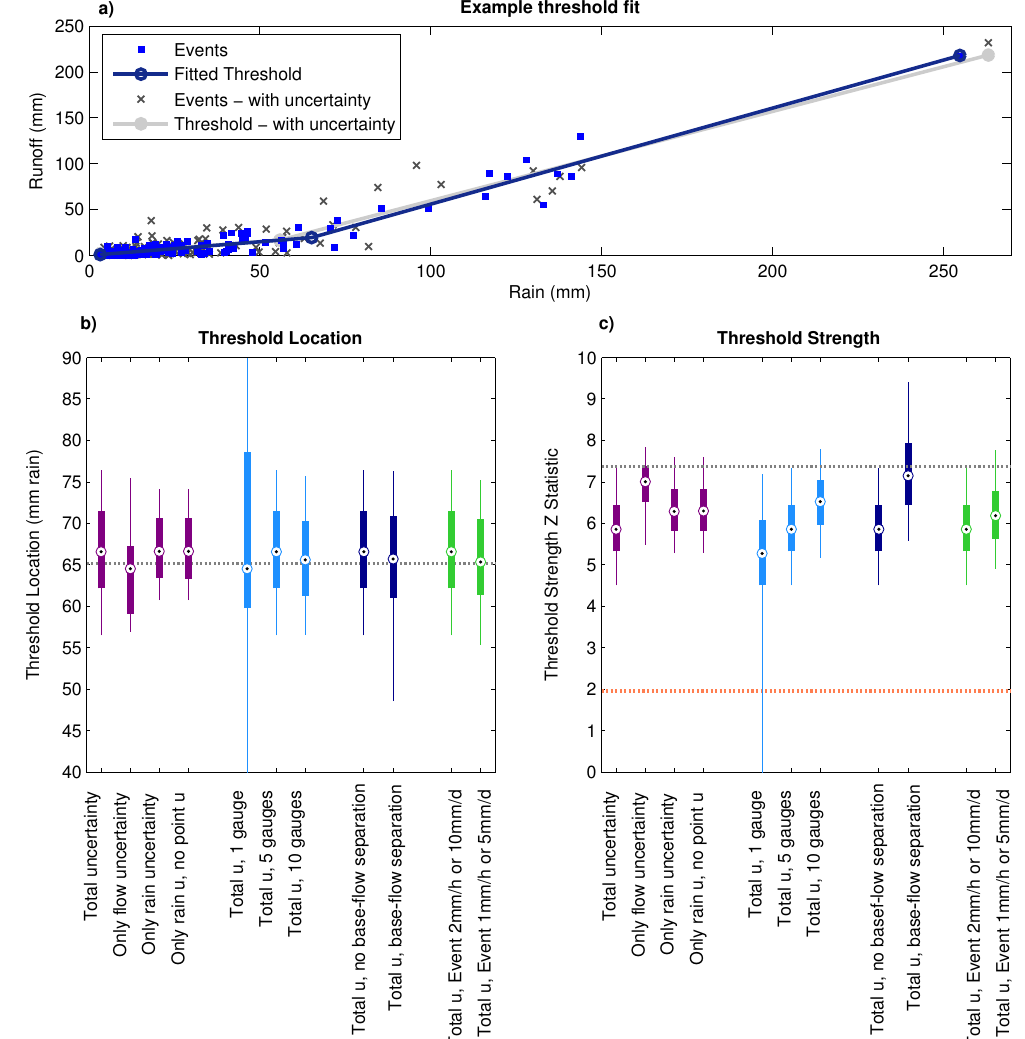
Figure 10. (a) Example of the threshold fitting procedure without (blue) and with (grey, one-rain-gauge scenario) uncertainty (u). Boxplots of (b) threshold location and (c) threshold strength in the Mahurangi catchment, under different data and subjective uncertainty scenarios. Horizontal grey lines show baseline signature values from the optimal rating-curve and precipitation data. The orange line in Fig. 9c shows the value above which the change in slope of the rainfall–runoff relationship is significant at the 5% level. Boxplot whiskers for the uncertainty distribution in the one-rain-gauge scenario are truncated for clarity. The total uncertainty scenario used 1raingauge10km − 2